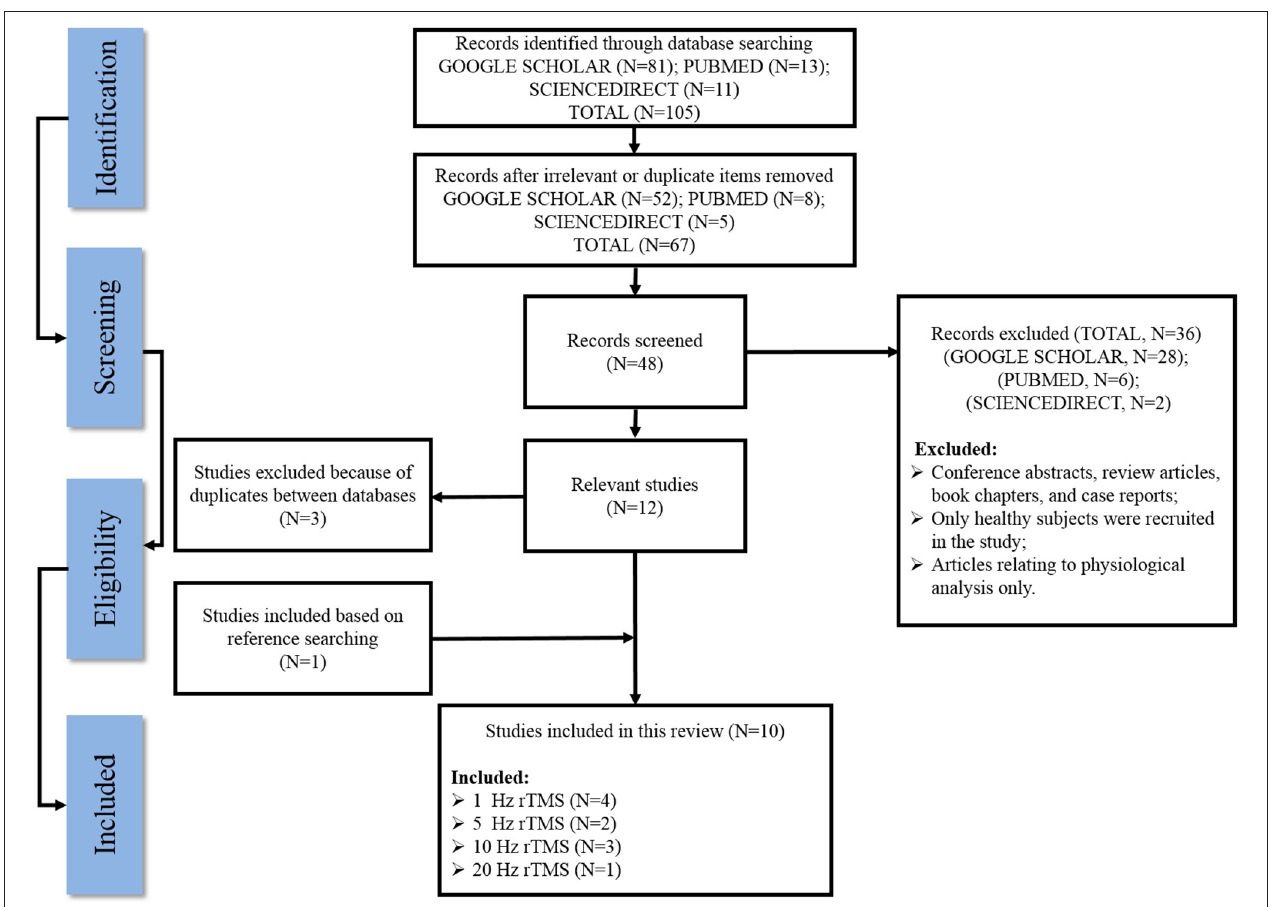
FIGURE 1 | Flow diagram of the literature inclusion and exclusion